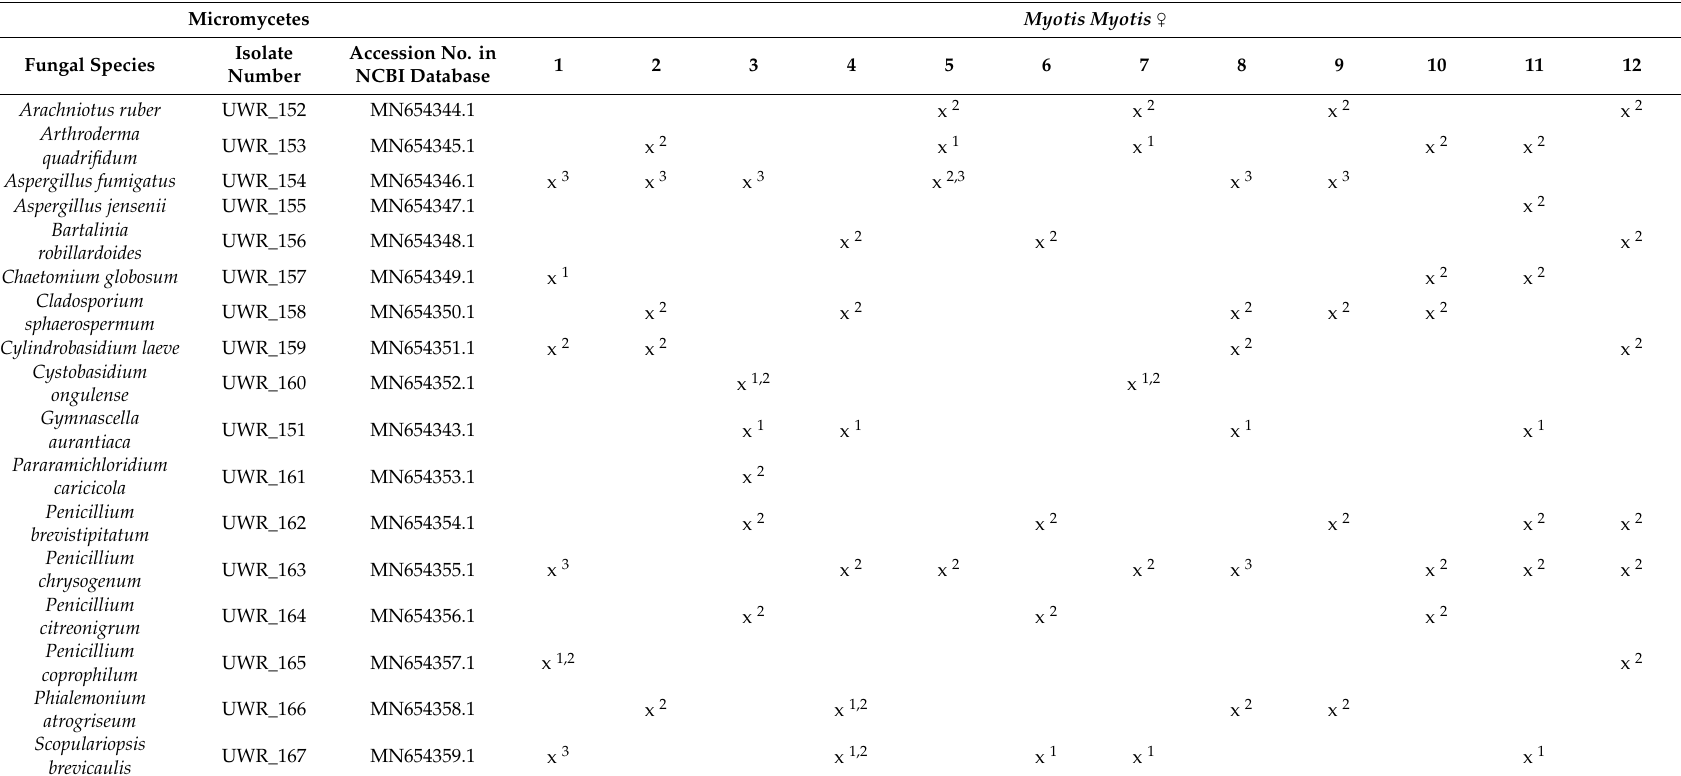
Table 1. Diversity of fungal species isolated from the wing membranes of 12 female greater mouse-eared bats ( Myotis myotis ).